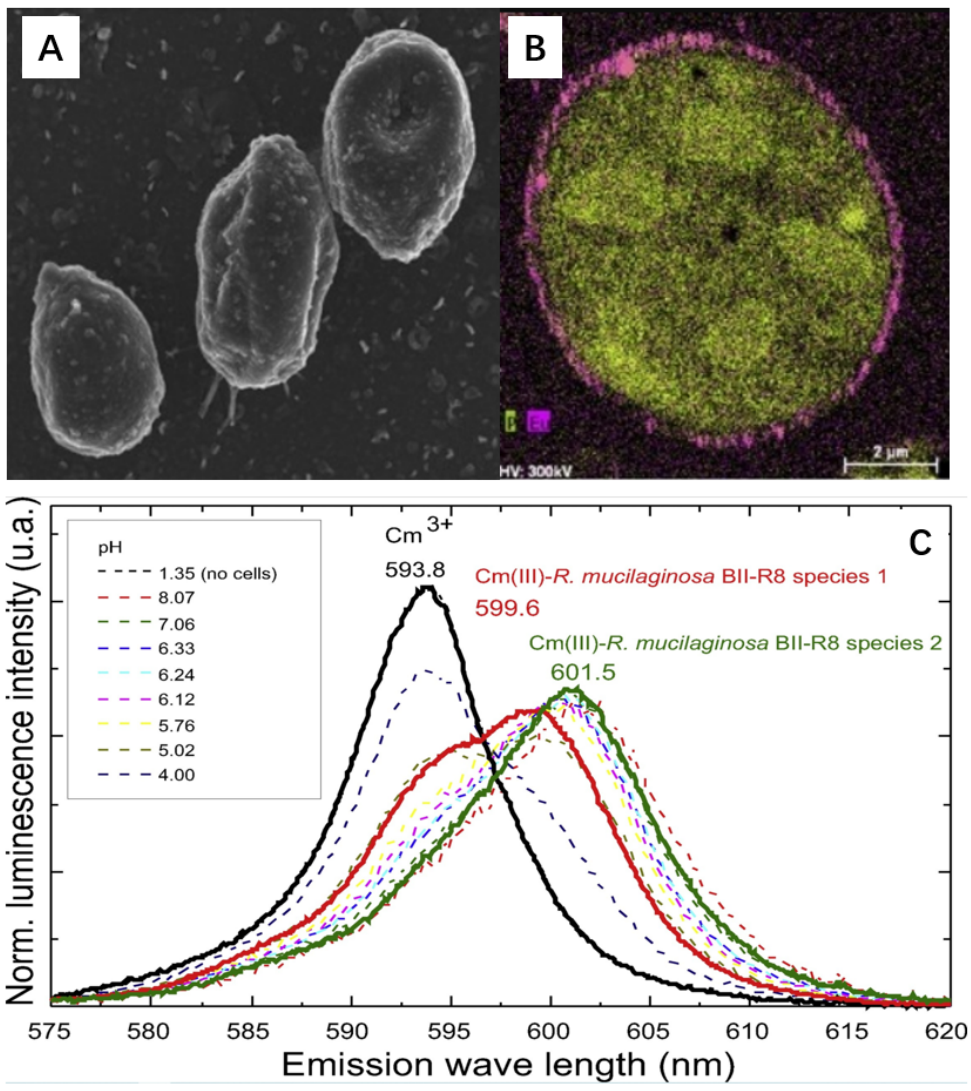
Figure 3. SEM image of R. mucilaginosa BII-R8 ( A ), phosphorus (light green) and Eu(III) (pink color) mapping image in STEM-HAADF micrographs of thin sections of R. mucilaginosa BII-R8 treated with 1 mM Eu (III) for 48 h ( B ), and luminescence emission spectra of 0.3 μ M Cm(III) in 0.1 M NaClO 4 measured as a function of pH at a fixed biomass concentration of 0.45 g dry weight /L ( C ). Reorganized from TOC . Reprinted with permission from ref. [29]. Copyright 2021 Elsevier .